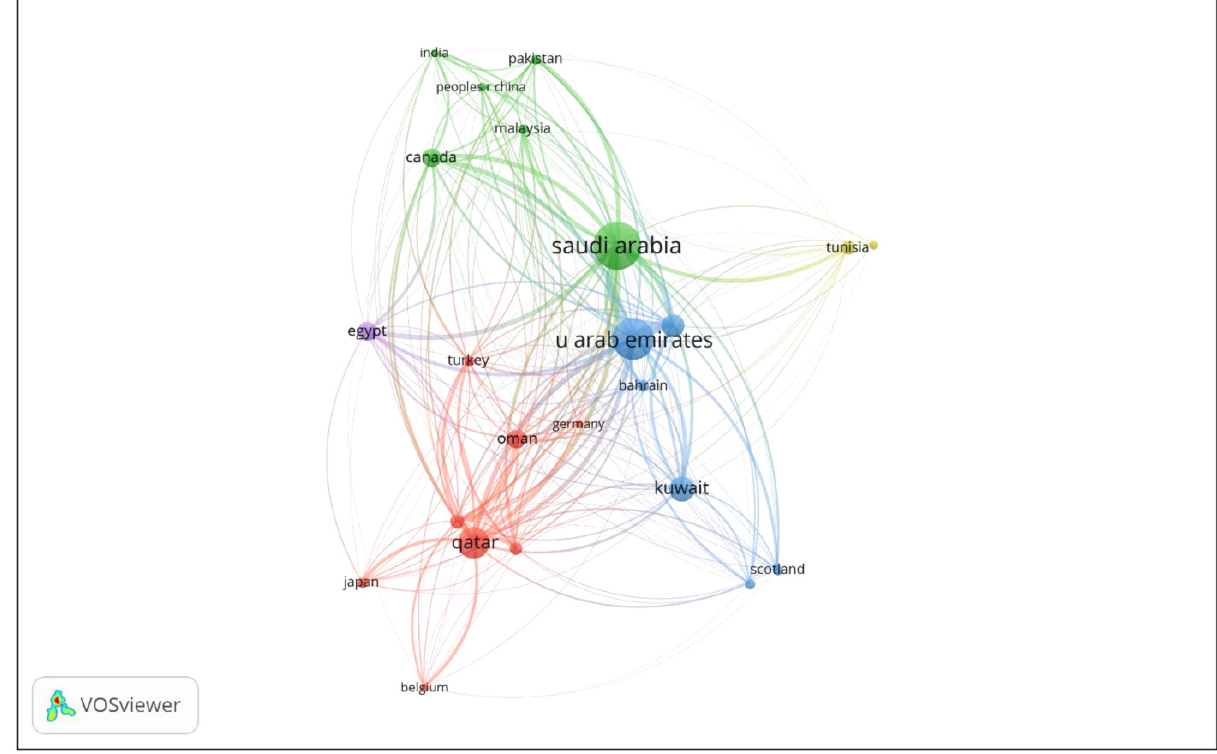
Figure 4. Bibliographic coupling among nations with three or more publications. (generated using VOSViewer software).